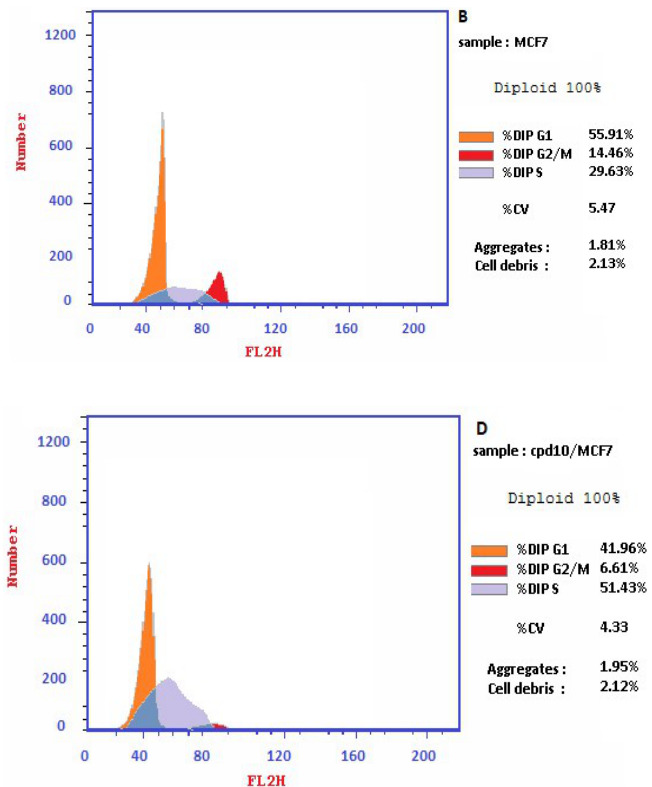
Figure 5. Cell cycle analysis and the effect of the target 10 on the percentage of V-FITC-positive annexin staining in MCF-7 cells in comparison with the control. Table 3. Kinase inhibitory assessment of the promising derivatives 8 , 10 and 21 against EGFR, VEGFR-2 and CDK-2/cyclinA2 comparing with erlotinib, sorafenib and roscovitine, respectively. Compound